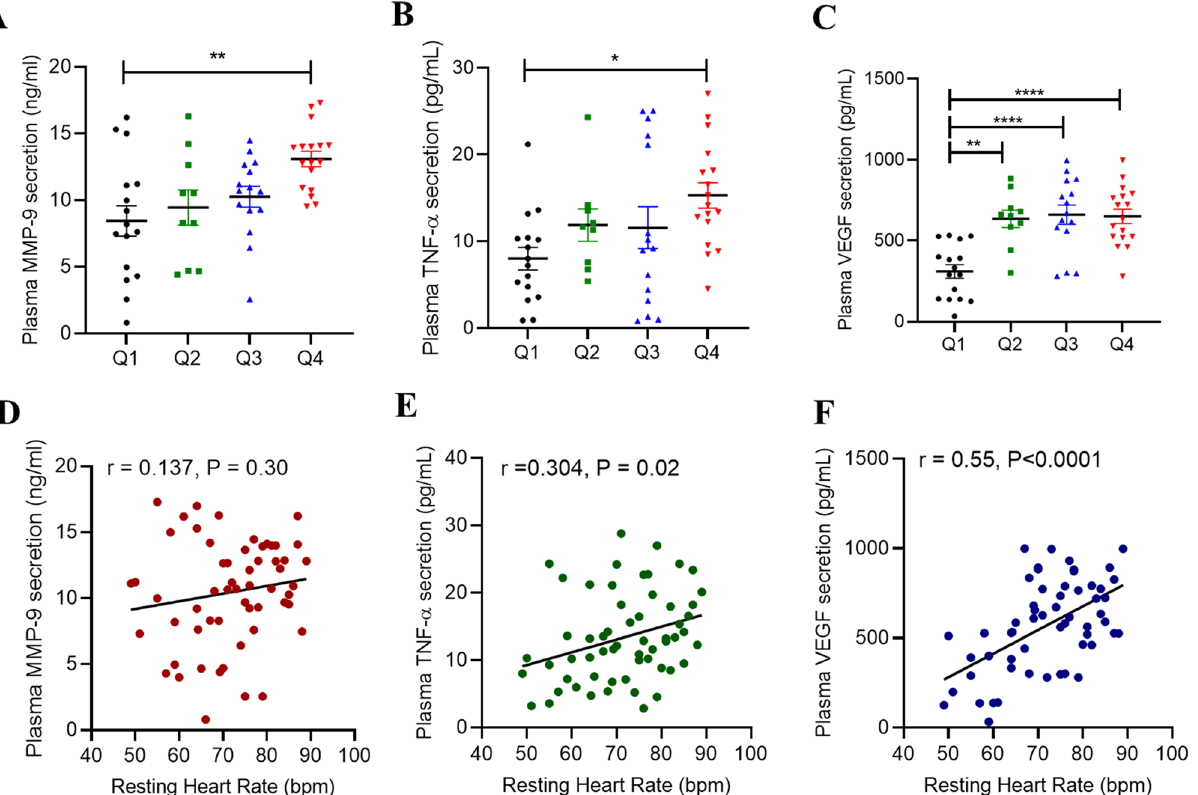
Figure 2. Elevated RHR is associated with obesity-inflammatory markers in the plasma. Plasma levels of obesity related cytokines secretion of MMP-9 ( A ), TNF-α ( B ) and VEGF ( C ) was determined by ELISA. Pearson’s correlation coefficient and linear regression analysis was conducted to investigate the relationship between secreted cytokines and RHR ( D – F ). All data are expressed as mean ± SD. P ≤ 0.05 was considered statistically significant (*P < 0.01; **P < 0.001, ***P < 0.0001).